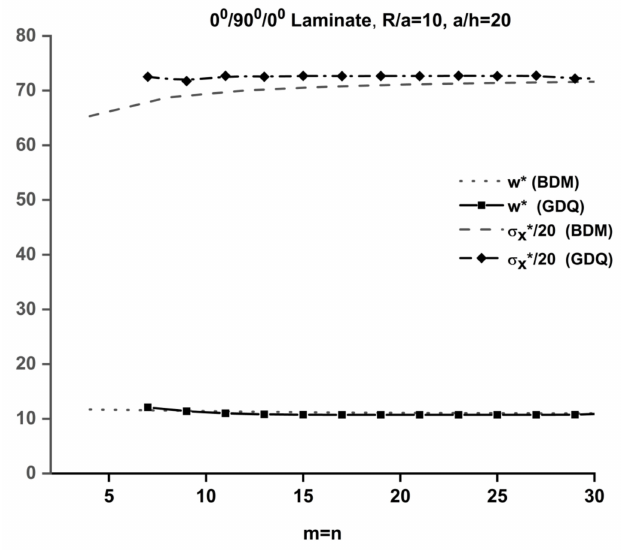
Figure 2. Convergence of displacements, w ∗ , and stresses, σ x ∗ , of a moderately thick ( a / h = 20) and symmetric cross-ply (0 ◦ /90 ◦ /0 ◦ ) spherical panel (R/ a =